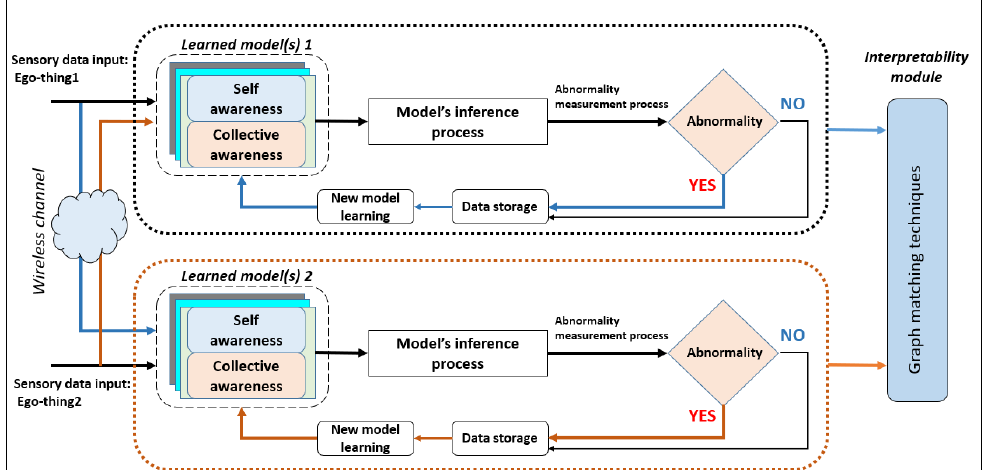
Figure 3. General block diagram of model testing and continual